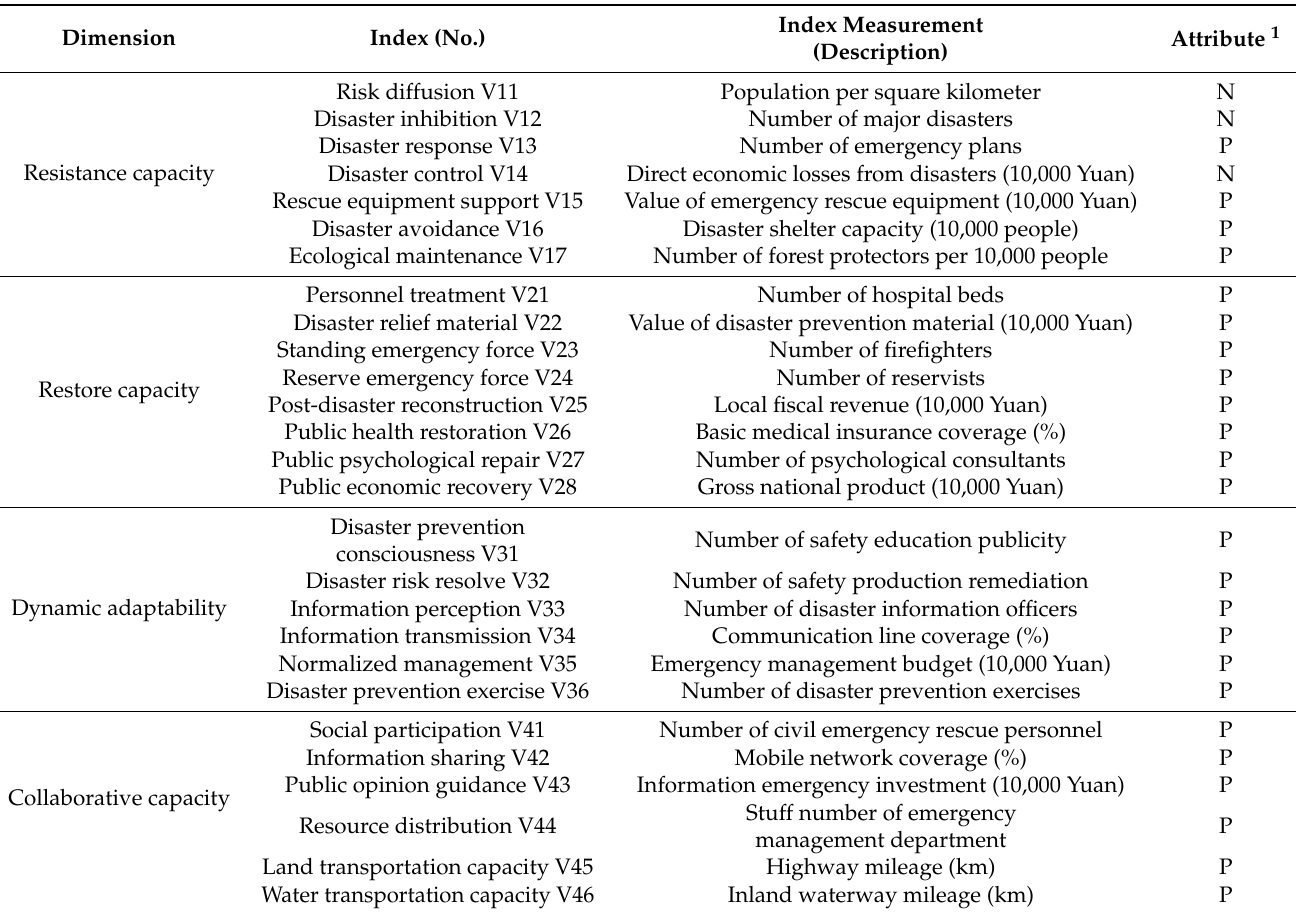
Table 1. Local emergency resilience evaluation